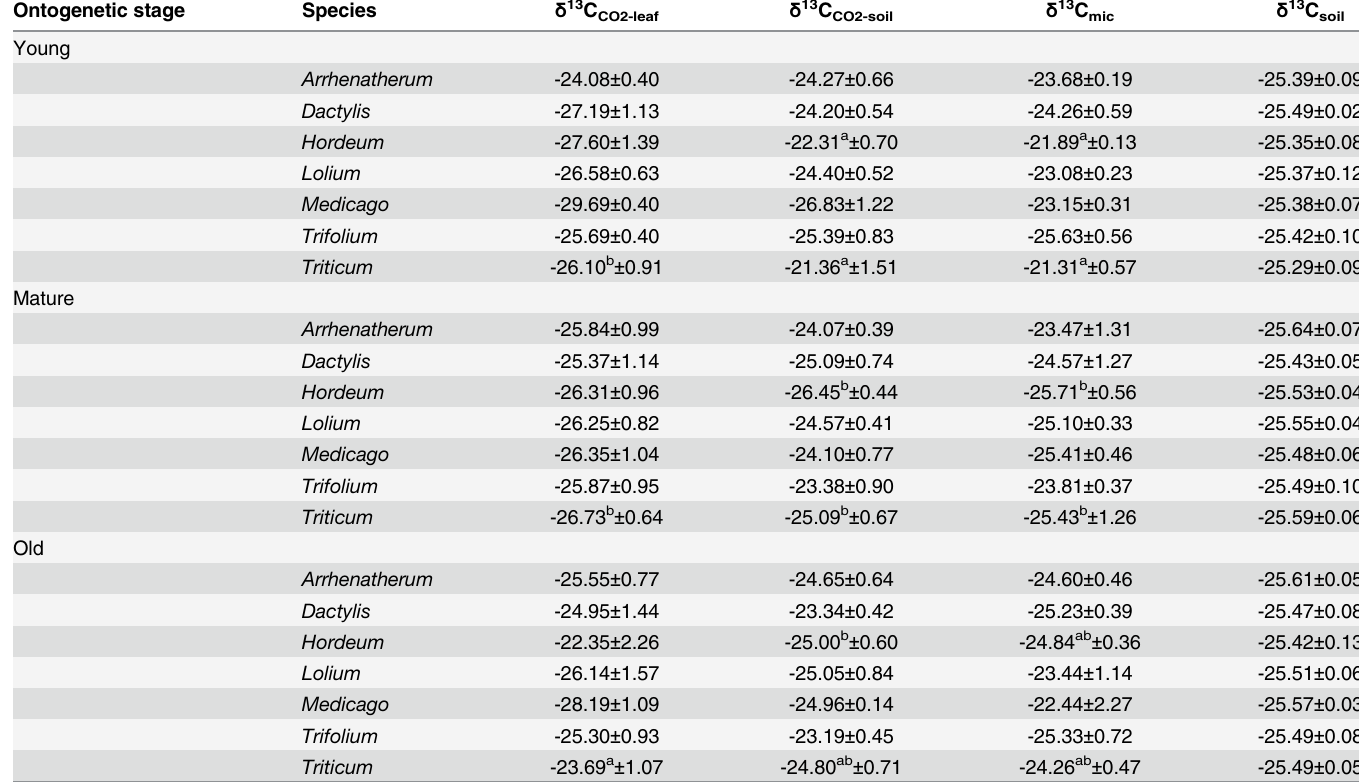
Table 2. δ 13 C values of leaf-respired CO 2 ( δ 13 C CO2-leaf ), soil-respired CO 2 ( δ 13 C CO2-soil ), microbial biomass ( δ 13 C mic ) and bulk soil δ 13 C ( δ 13 C soil ) at three ontogenetic stages (young foliage, “ young ” ; maximum growth rate, “ mature ” ; beginning of senescence, “ old ” ) in seven species ( Arrhe- natherum elatius , Dactylis glomerata , Hordeum vulgare , Lolium perenne , Medicago sativa , Trifolium pratense , Triticum aestivum ). Values are given as mean ± 1SE (n = 6). Within one column, different letters indicate significant differences between ontogenetic stages within a species (p (cid:5) 0.05). Note that only significant differences are